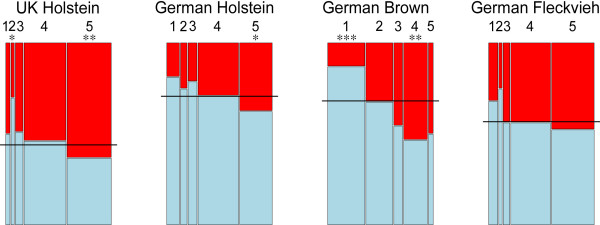
Diplotype Frequencies. Diplotype frequencies in UK Holstein, German Holstein, German Brown and German Fleckvieh BSE affected (red) and control (light blue) animals. Numbers above the columns represent the haplotypes: (1) 23ins-12ins/23ins-12ins, (2) 23ins-12ins/23del-12ins, (3) 23del-12ins/23del-12del, (4) 23ins-12ins/23del-12del and (5) 23del-12del/23del-12del. The horizontal black lines indicate the expected proportions of cases and controls in each class. The thickness of the columns is proportional to the diplotype frequency. Asterisks indicate the level of significance: * < 0.05, ** < 0.01, *** < 0.001.